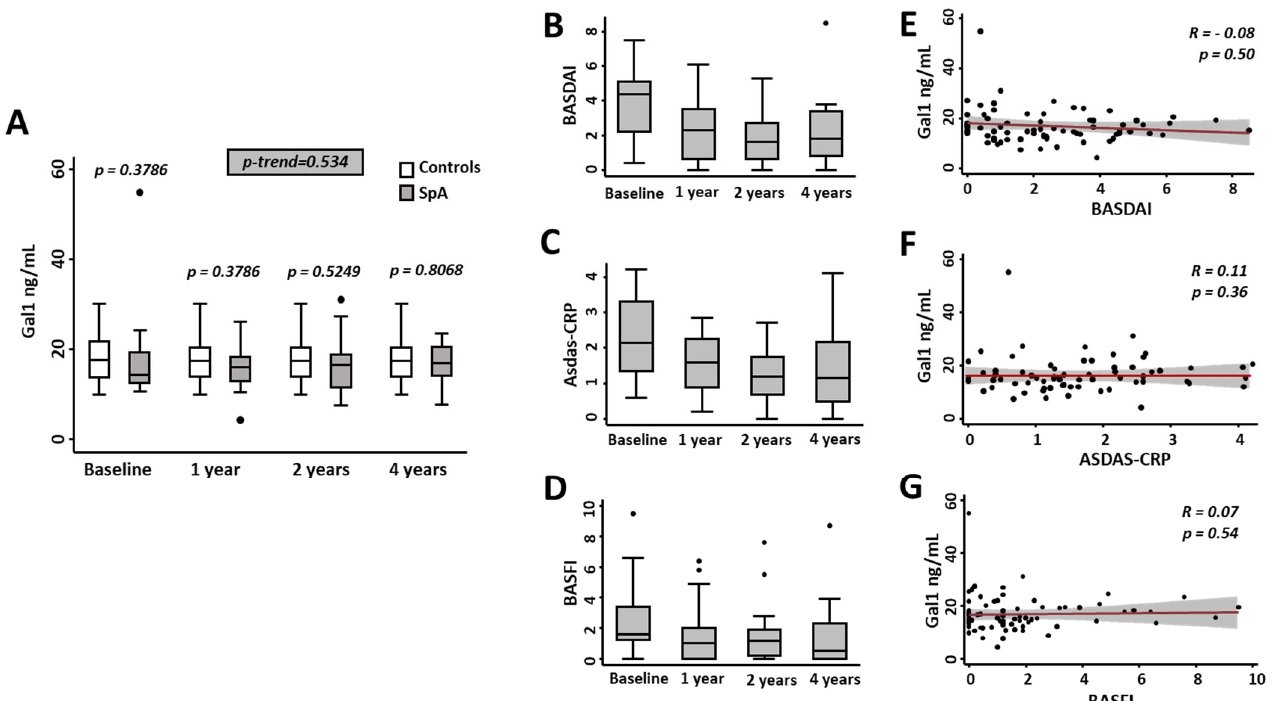
Figure 1. Gal1 serum levels do not correlate with clinical severity parameters in early spondyloar ‐ thritis. ( A ) Determination of Gal1 serum levels with ELISA in control (mechanical lower back pain patients) and early spondyloarthritis (SpA) patients during the follow ‐ up. Gal1 serum levels were adjusted by age as described in the methods section. Statistical significance for the trend of Gal1 in the follow ‐ up visits in early SpA patients was determined with Cuzick’s non ‐ parametric test. Sig ‐ nificance threshold was set at p ‐ trend <0.05. ( B ) Evolution along the follow ‐ up of disease activity was assessed with BASDAI or ( C ) ASDAS ‐ CRP, and disability was assessed with BASFI ( D ) in early spondyloarthritis patients. Absence of correlation of Gal1 serum levels with BASDAI ( E ), ASDAS ‐ CRP ( F ) and BASFI ( G ) in early spondyloarthritis patients. In panels A to D, data are shown as interquartile range (p75 upper edge of box, p25 lower edge, p50 midline) as well as p95 (line above box) and p5 (line below). Dots represent outliers. In panels E to G, data are shown as dot plots and their fitted linear prediction with 95% confidence interval (grey shadow) using the two ‐ way com ‐ mand of Stata with the lfitci option. Spearman’s rho test was used to determine the level of signifi ‐ cance .